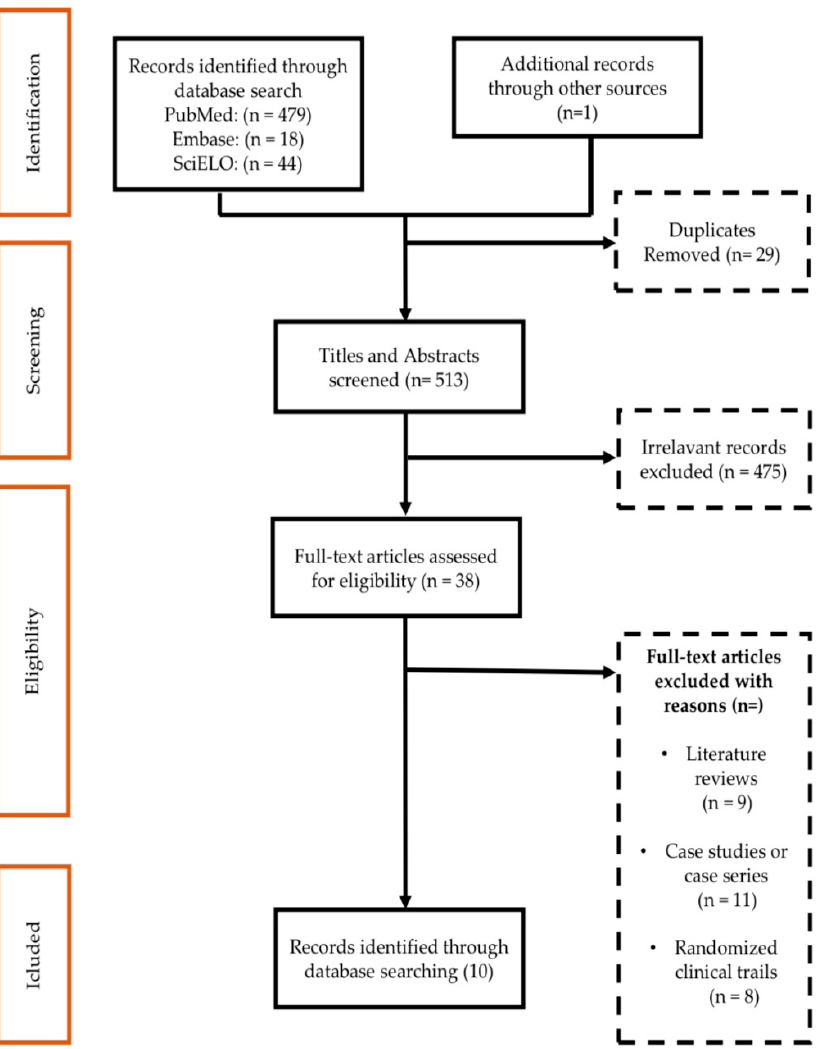
Figure 1. PRISMA schematic selection process of the included studies at each stage of the screening process.